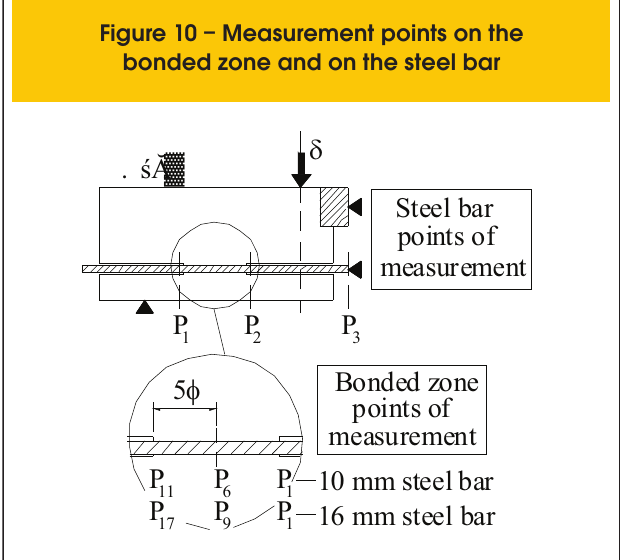
Figure 10 – Measurement points on the bonded zone and on the steel bar